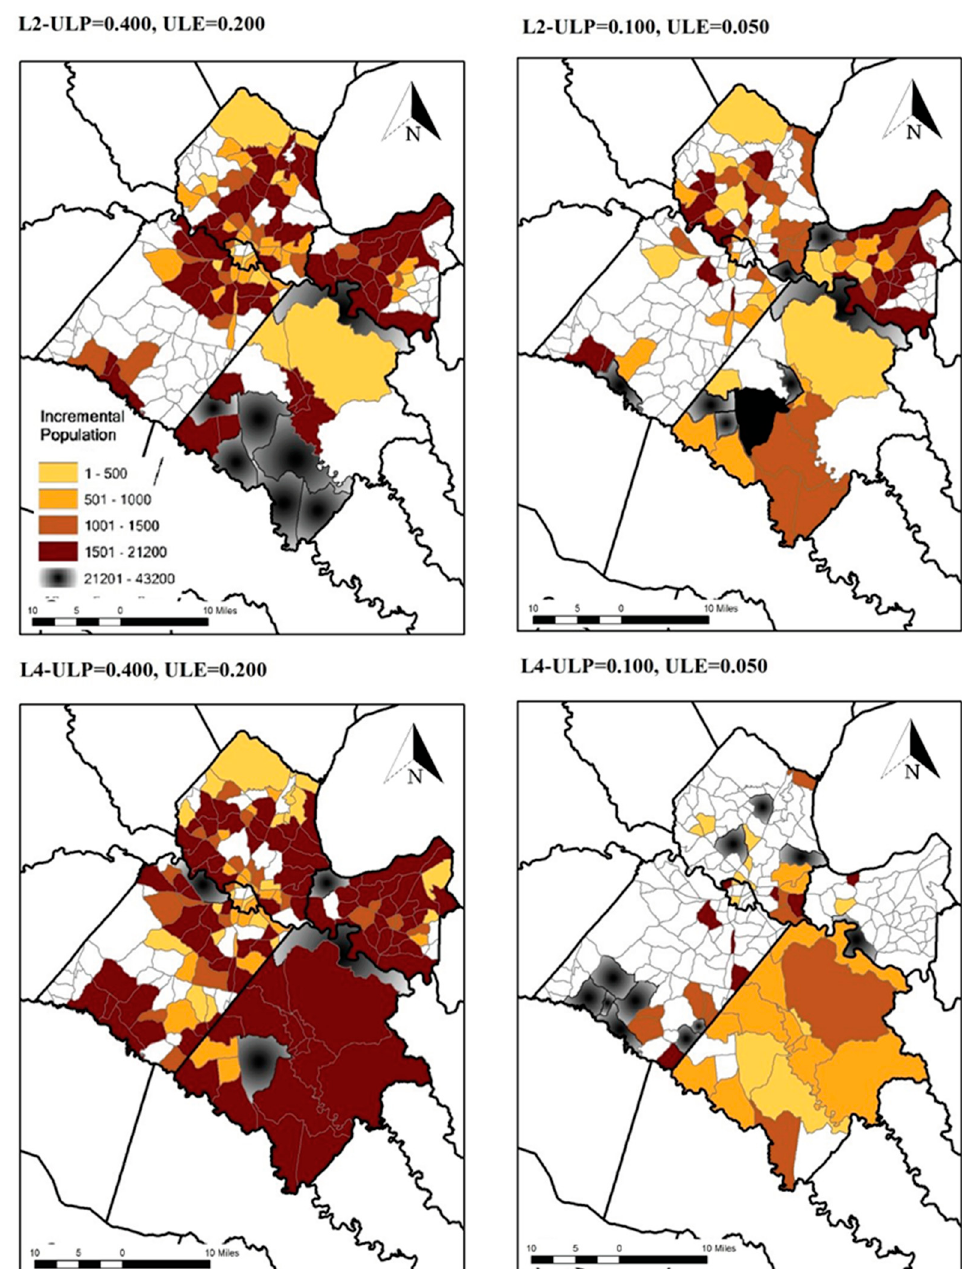
Figure 8. Optimal Allocation of Incremental Population.